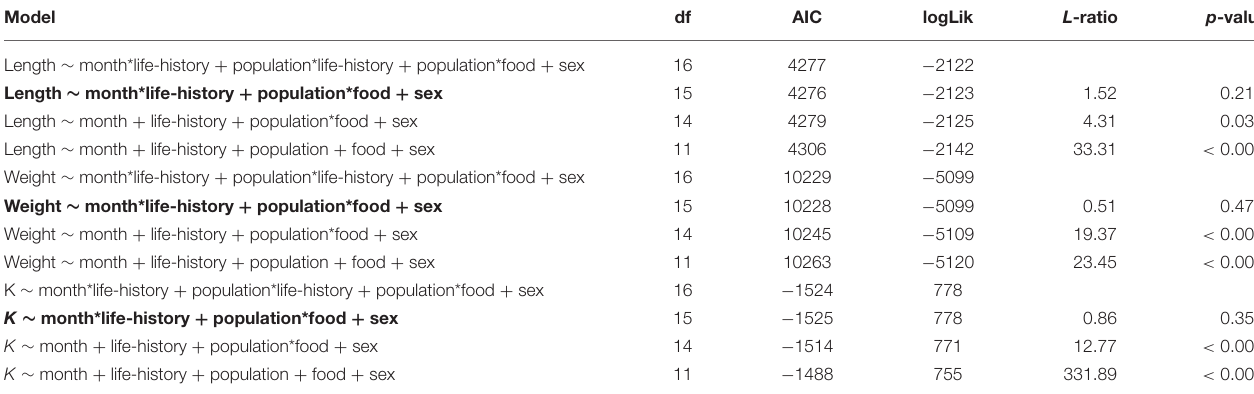
TABLE 4 | Results of the mixed effect model analysis for length, weight and condition factor ( K ) trajectories of brown trout in the experiment with life-history classed as either smolts (i.e., migratory) or freshwater mature across the study period. Model df AIC logLik L -ratio p -value